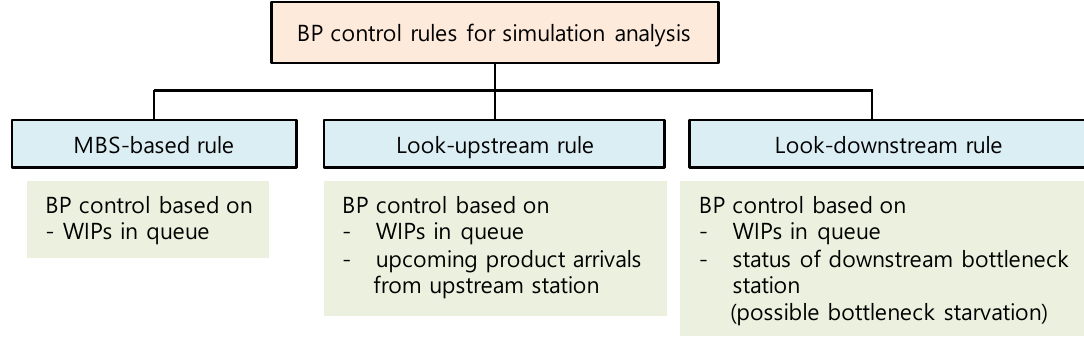
Figure 3. Three BP control rules under consideration.